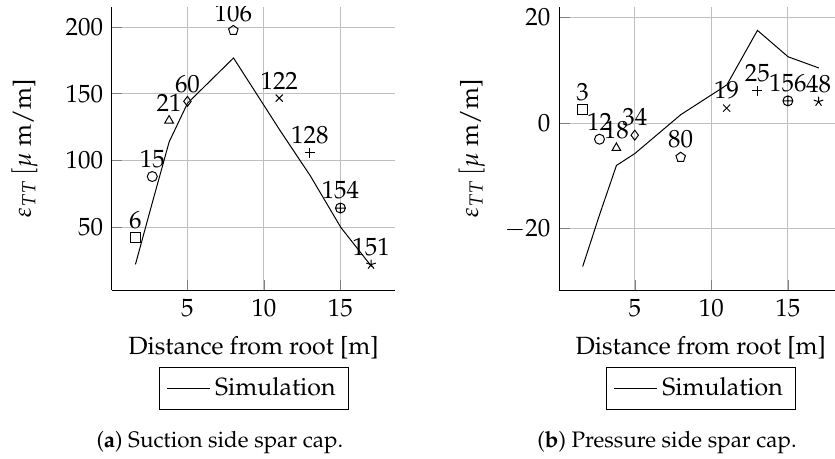
Figure A15. Strain comparison ε LL for Mxmin load case.